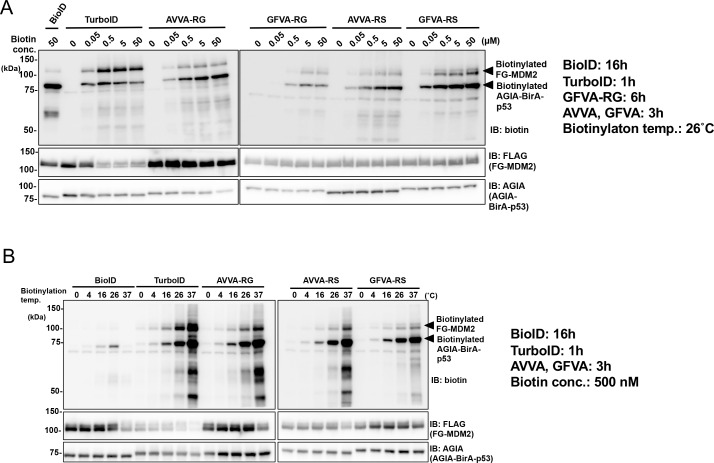
Condition for in vitro biotinylation.Biotinylation of FG-MDM2 was performed using BioID, TurboID, AVVA-RG, GFVA-RG, AVVA-RS, or GFVA-RS fused to p53. (A) Biotin concentration and (B) reaction temperature were examined for in vitro proximal biotinylation. As a control, expression of each BirA-p53 and MDM2 was detected using anti-AGIA antibody and anti-FLAG antibody, respectively.